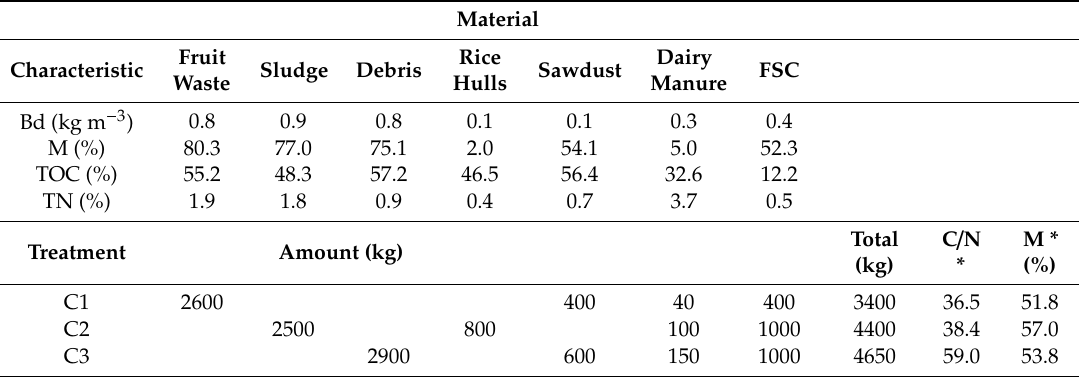
Table 1. Characteristics and proportion of materials used to achieve desirable attributes in the compostable